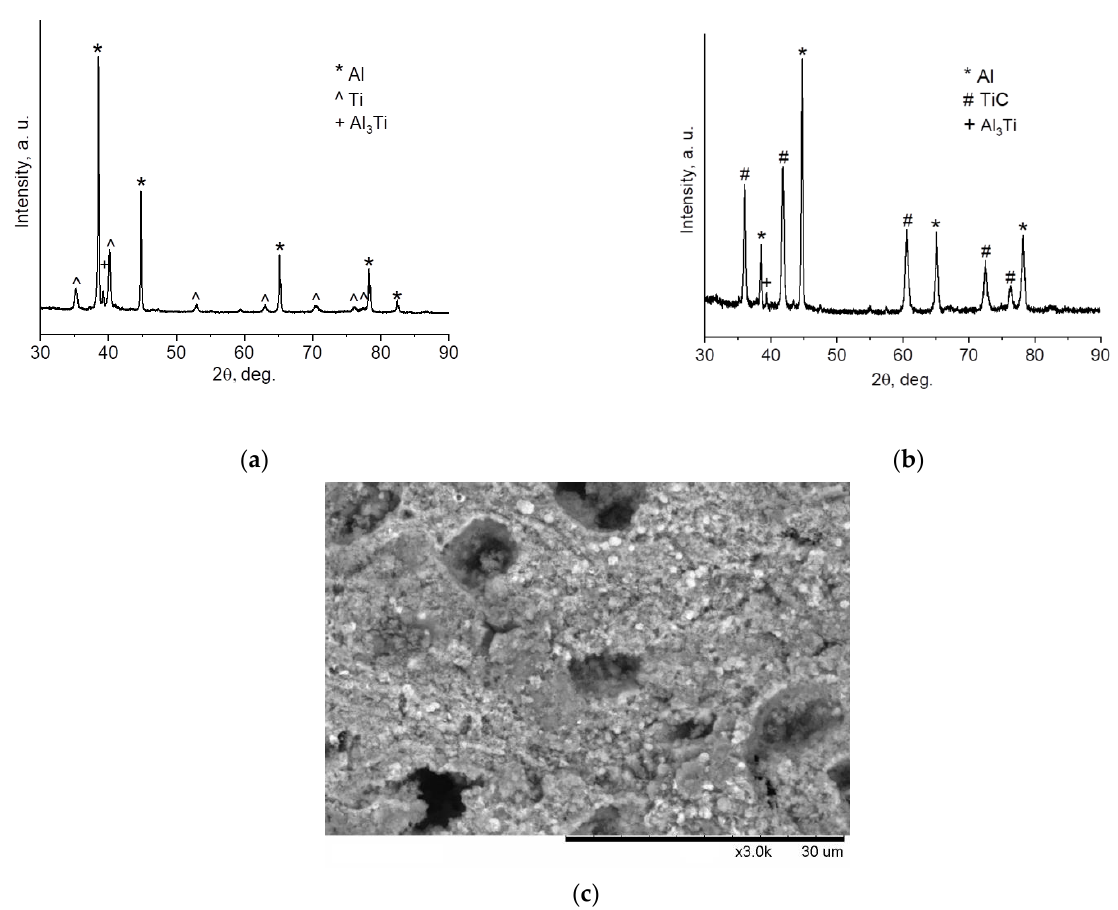
Figure 2. X-ray diffraction (XRD) pattern of the mechanically milled Ti – C – 3Al powder mixtures, milling time 1 min ( a ), XRD pattern ( b ) and fracture surface ( c ) of the material obtained by consolidation of the mechanically milled mixture by SPS at 550 °C for 3 min followed by annealing at 800 °C for 10 min.